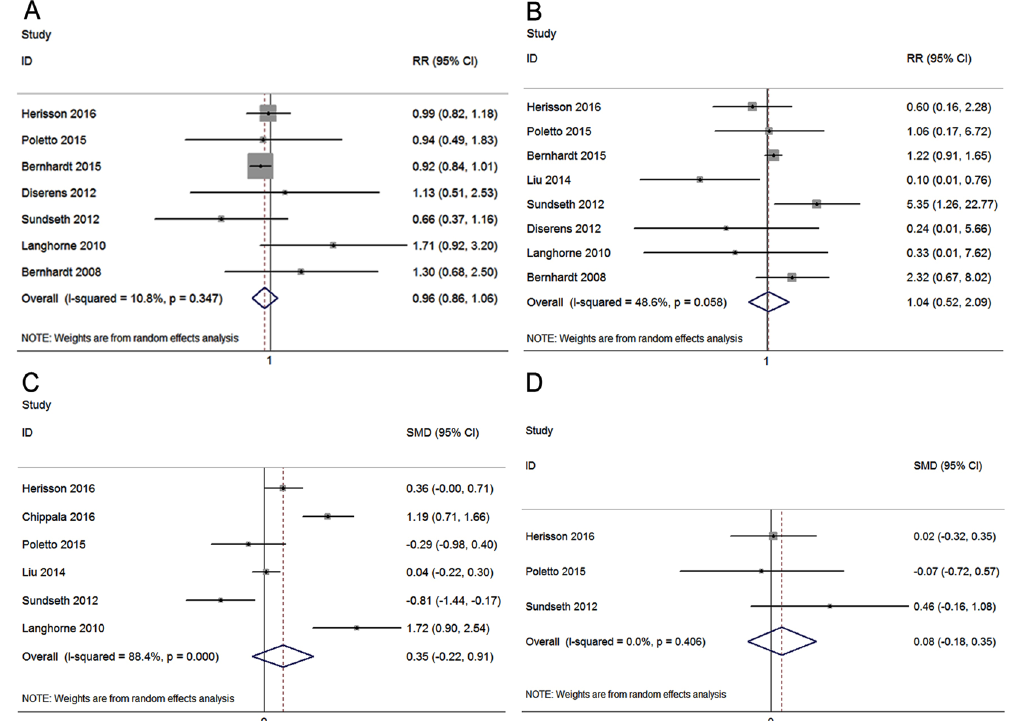
Figure 2. Forest plots of efficacy and safety outcomes of very early mobilization at 3 months. The diamond indicates the estimated relative risk (RR) or standardized mean differences (SMD) (95% confidence interval). The p-value showed on each figure is for heterogeneity test. The modified Rankin Scale (0–2): p for overall effect = 0.40, Q = 6.73 (A) . Mortality: p for overall effect = 0.90, Q = 13.62 (B) . Barthel Index: p for overall effect = 0.23, Q = 43.22 (C) . National Institutes of Health Stroke Scale: p for overall effect = 0.54, Q = 0.11 (D) .